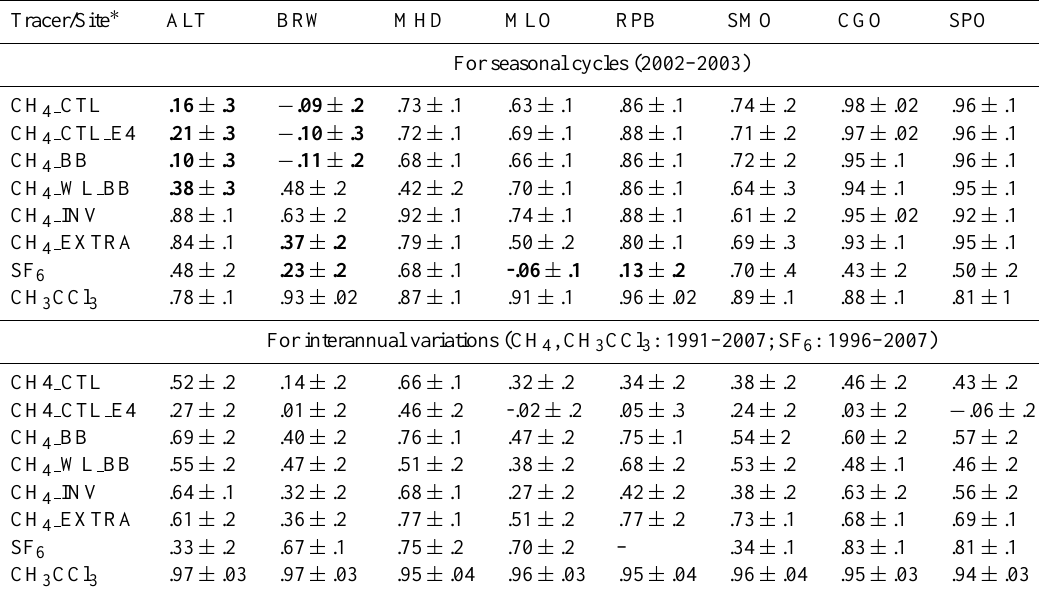
Table 4. Average (across all models) correlation coefficient ( r ) between model simulated and observed seasonal cycles and interannual variation of CH 4 , SF 6 and CH 3 CCl 3